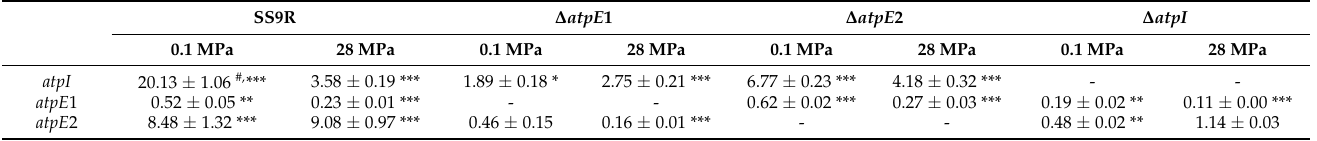
Table 1. The influence of cultural medium on the expression of ATPase genes in SS9R and the mutant